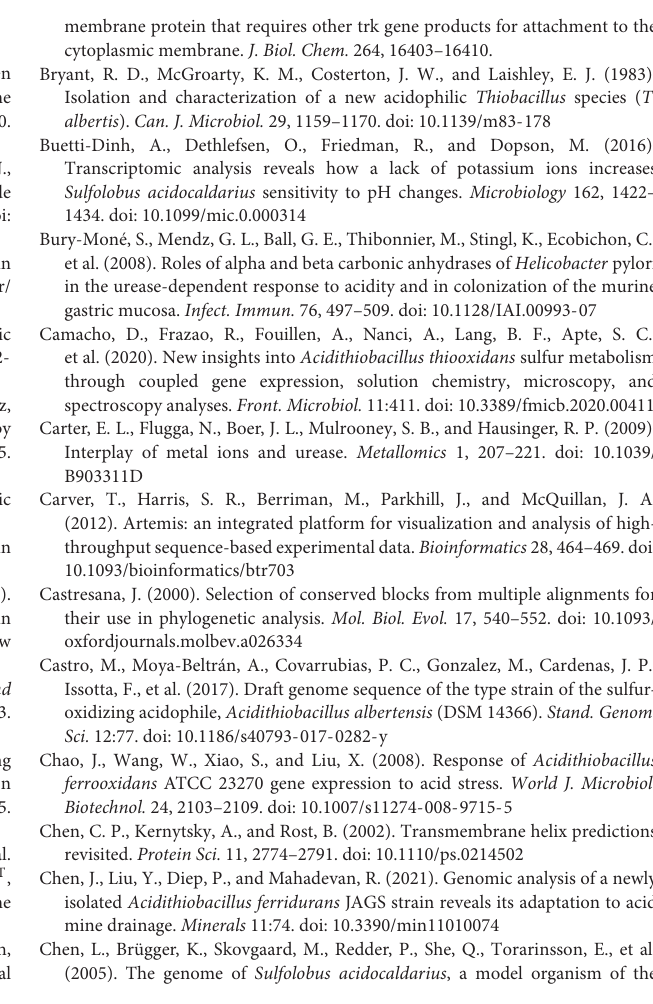
Supplementary Data Sheet 1 | List of conserved core genes in Acidithiobacillia class. Supplementary Data Sheet 2 | List of genes involved into first and second line of defense acid resistance in the Acidithiobacillia class. Supplementary Image 1 | Supplementary